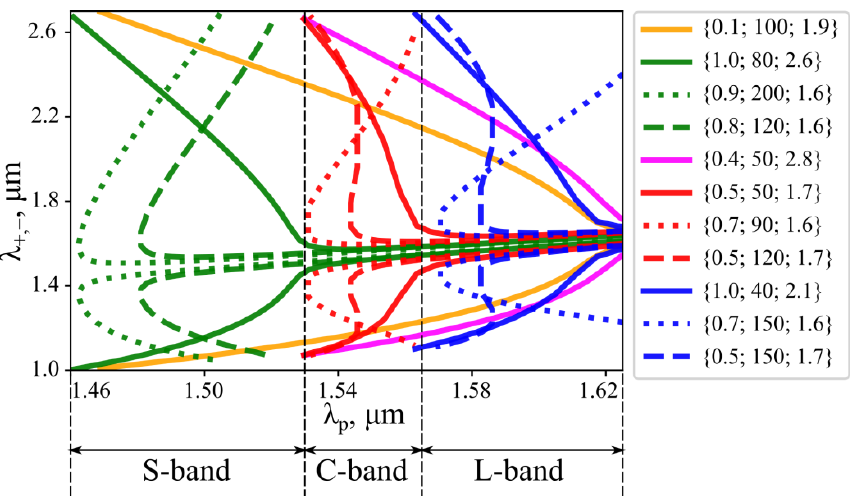
Figure 9. A few phase-matching curves optimized for FWM generation in different pump wavelength ranges: SCL-band (orange curve), S-band (green curves), CL-band (magenta curve), C-band (red curves), and L-band (blue curves). The upper branches correspond to λ − . Microresonator parameters are shown as { X ; R in µ m; b in µ